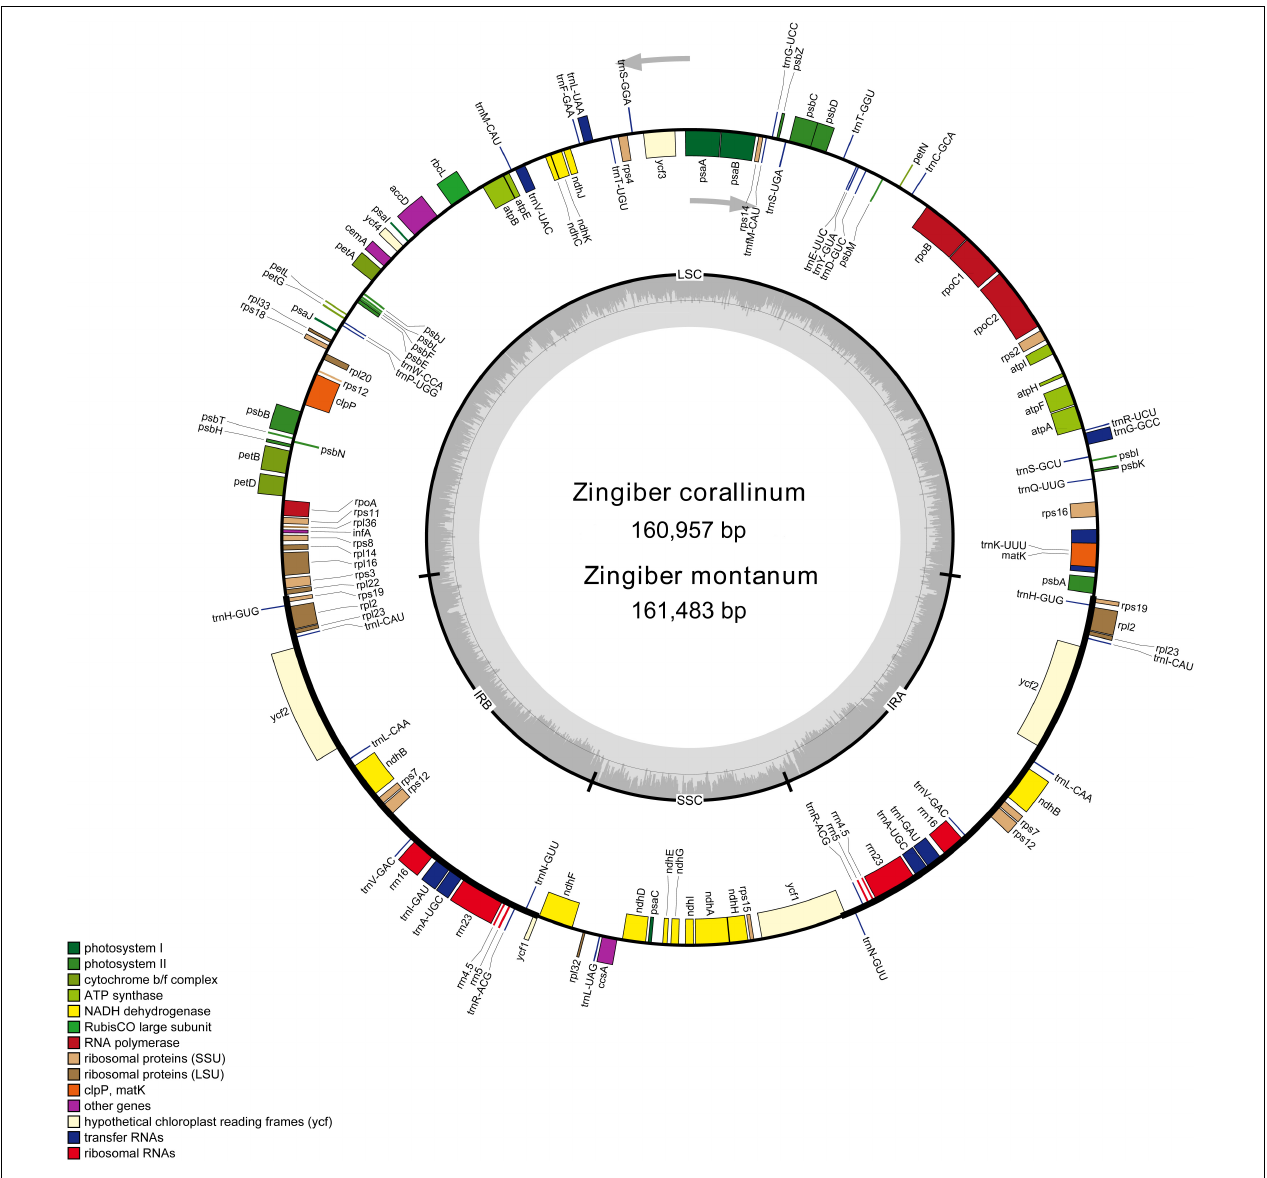
FIGURE 1 | Gene map of the Z. corallinum and Z. montanum complete chloroplast genome. Genes that are inside and outside the circle are transcribed clockwise and counterclockwise, respectively. Genes belonging to different functional groups are classified by different colors. The darker gray area in the inner circle corresponds to GC content, whereas the lighter gray area corresponds to AT